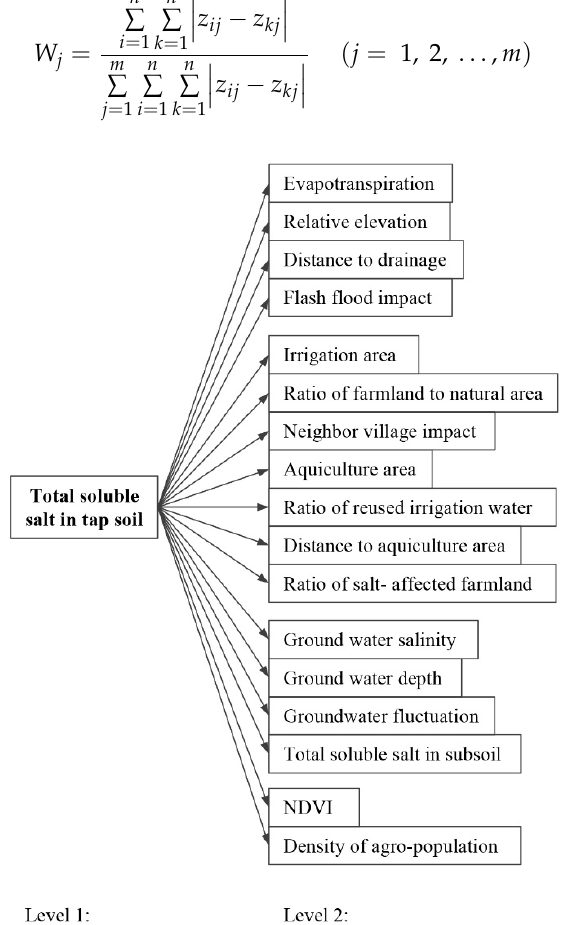
Figure 1. Two-level structure of the AHP model for the Irrigation Salinity Risk Assessment and Mapping.